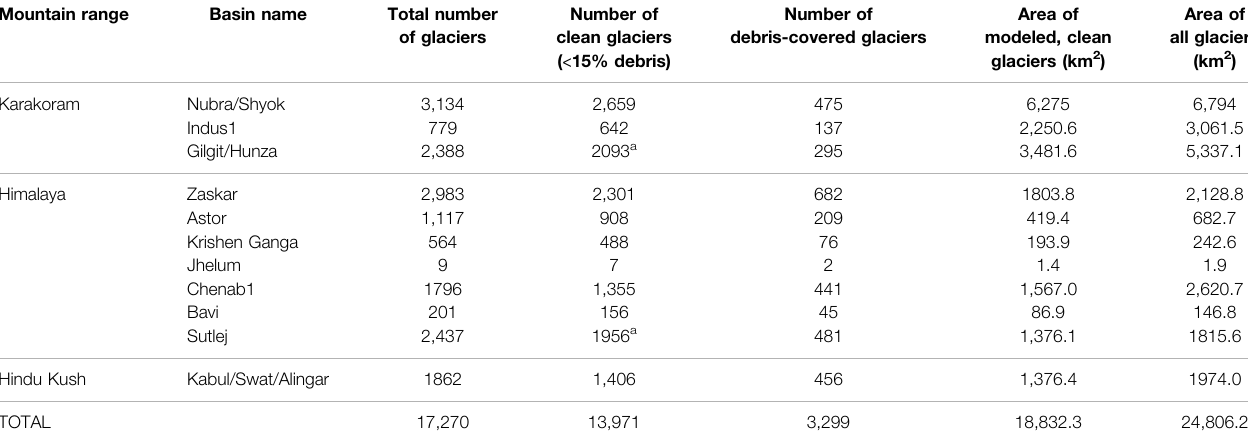
TABLE 1 | Inventory of glaciers in the Upper Indus Basin and the area of those modeled (Kraaijenbrink et al., 2017; RGI Consortium, 2017; Scherler et al., 2018). Mountain